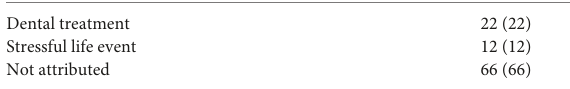
TABLE 2 Prevalence of oral symptoms, location, timing and pattern of pain and worst symptom, disease onset, number of doctors and typology of referrals, cause of disease and analysis of pain, psychological profile and quality of sleep in BMS